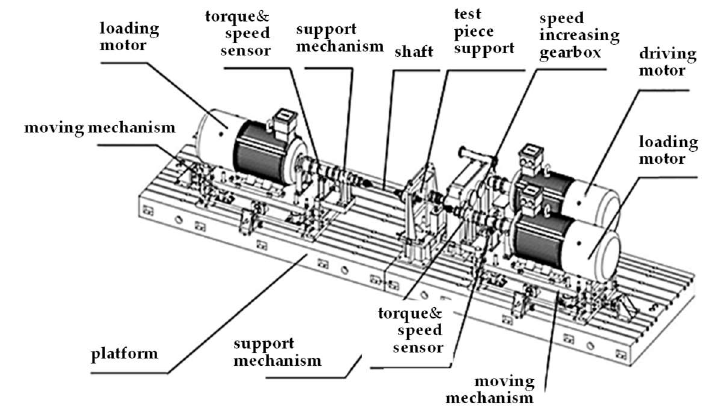
Figure 3. Two-dimensional schematic diagram of test platform.